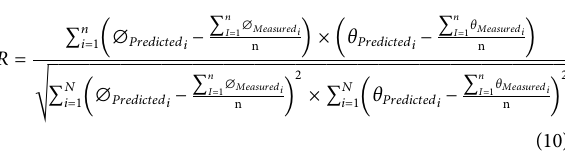
order to build this algorithm, data related to two wells, F1 and F2 (1511 data points), has been used, and in order to test this algorithm, data related to well F3 (1237 data points) has been used. Some data points in this study were outliers, and with outlier detection, they were removed from the main data collection. The input and output variables used in this research include: laterolog (LLS), PEF, Vp, porosity (NPHI), SGR, density (RHOB), CGR, Vs, caliper (CALI), resistivity (ILD), DT, PP. The statistical information related to the data related to this article is presented in Table 1. Among the equations that can be used to obtain relationships between variables is Spearman ’ s correlation coef fi cient (R).